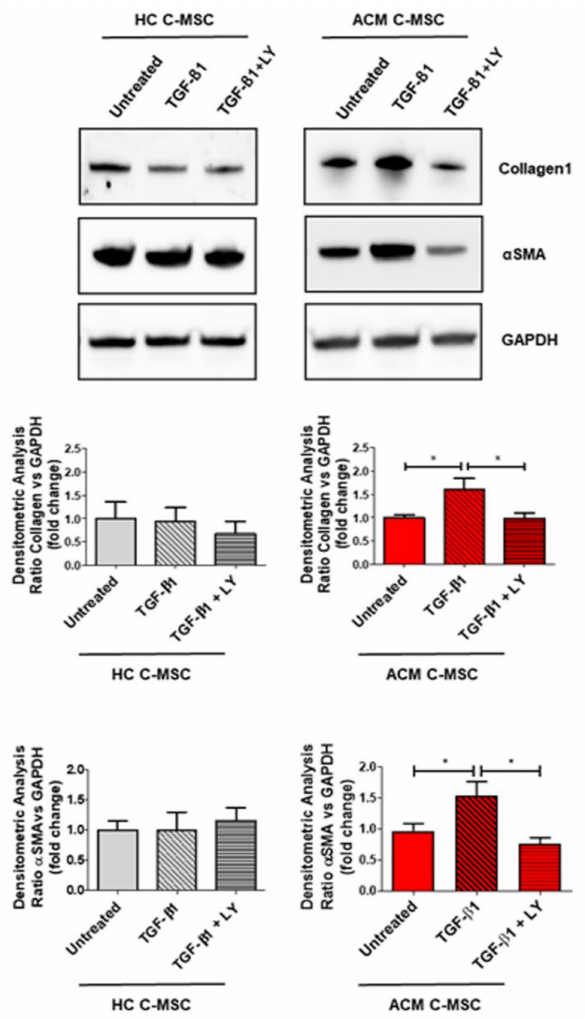
Figure 4. TGF- β 1 induces the overexpression of fibrosis-associated proteins. Following overnight low serum (2%) growth, cardiac mesenchymal stromal cells isolated from HC donors and ACM patients were stimulated with TGF- β 1 for 5 days in the presence or absence of LY364947 treatment. Representative images of Western blot analysis on fibrosis-associated proteins (Collagen1, α SMA) in total protein extracts of treated cells. Quantification of the protein abundance relative to GAPDH has been shown as fold change respect to untreated protein in the graphs and results are expressed as mean ± SEM, ( n = 3/group). One-way ANOVA and Bonferroni’s post-test: * p < 0.05.